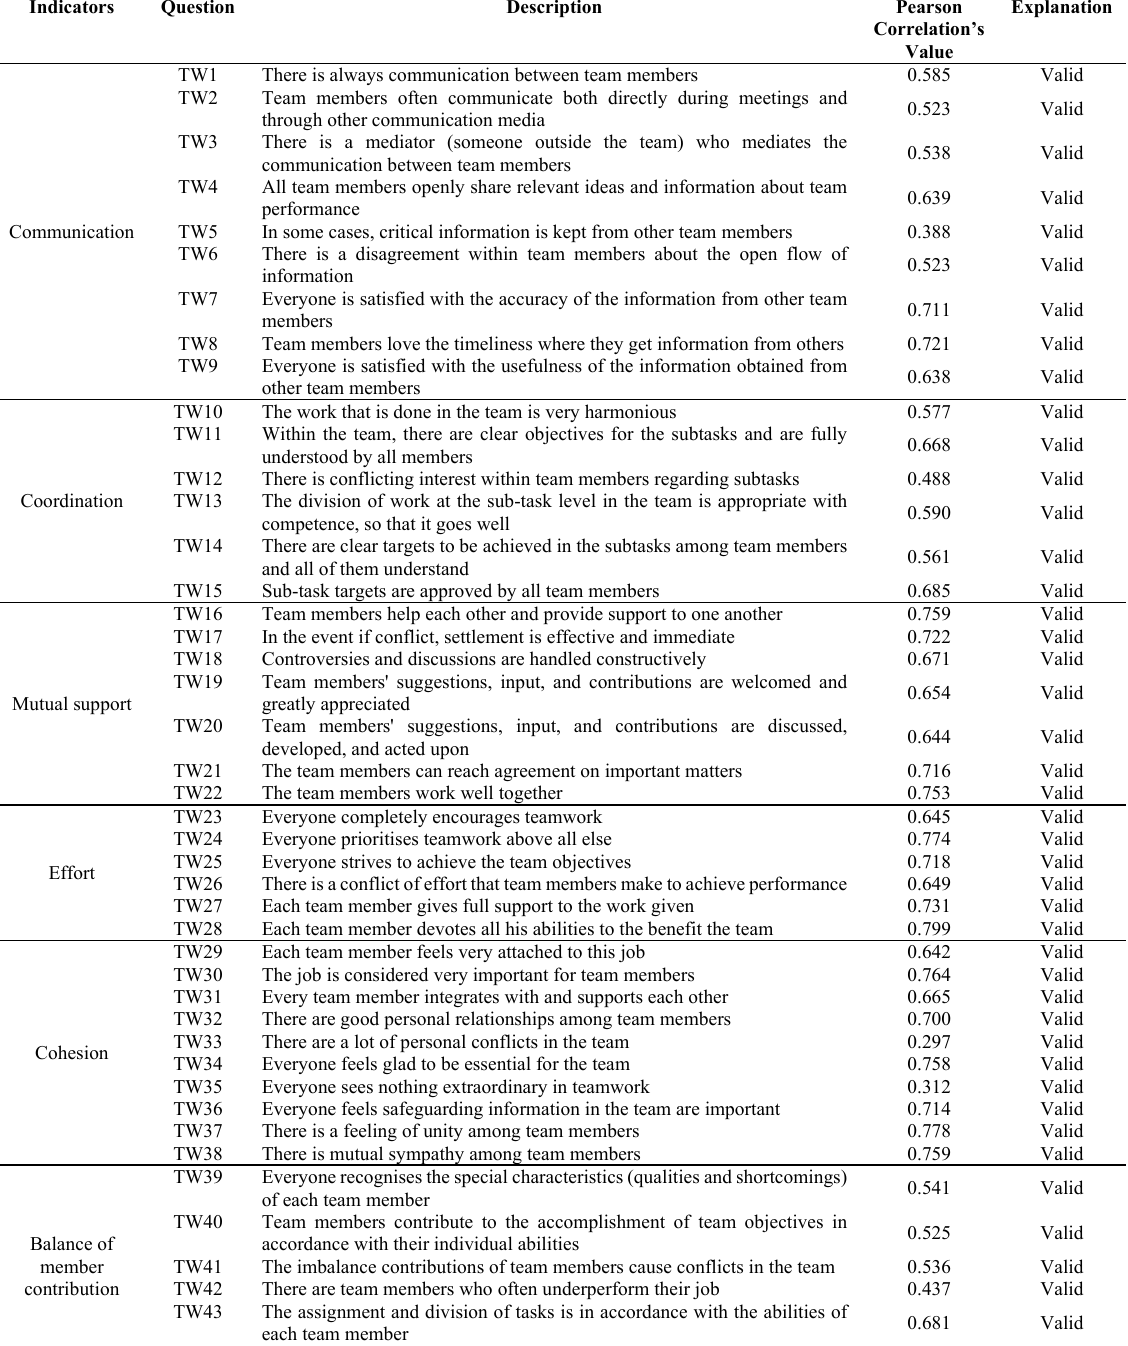
TABLE 1 T HE V ALIDITY T EST R ESULTS FOR T HE T EAMWORK Q UALITY I